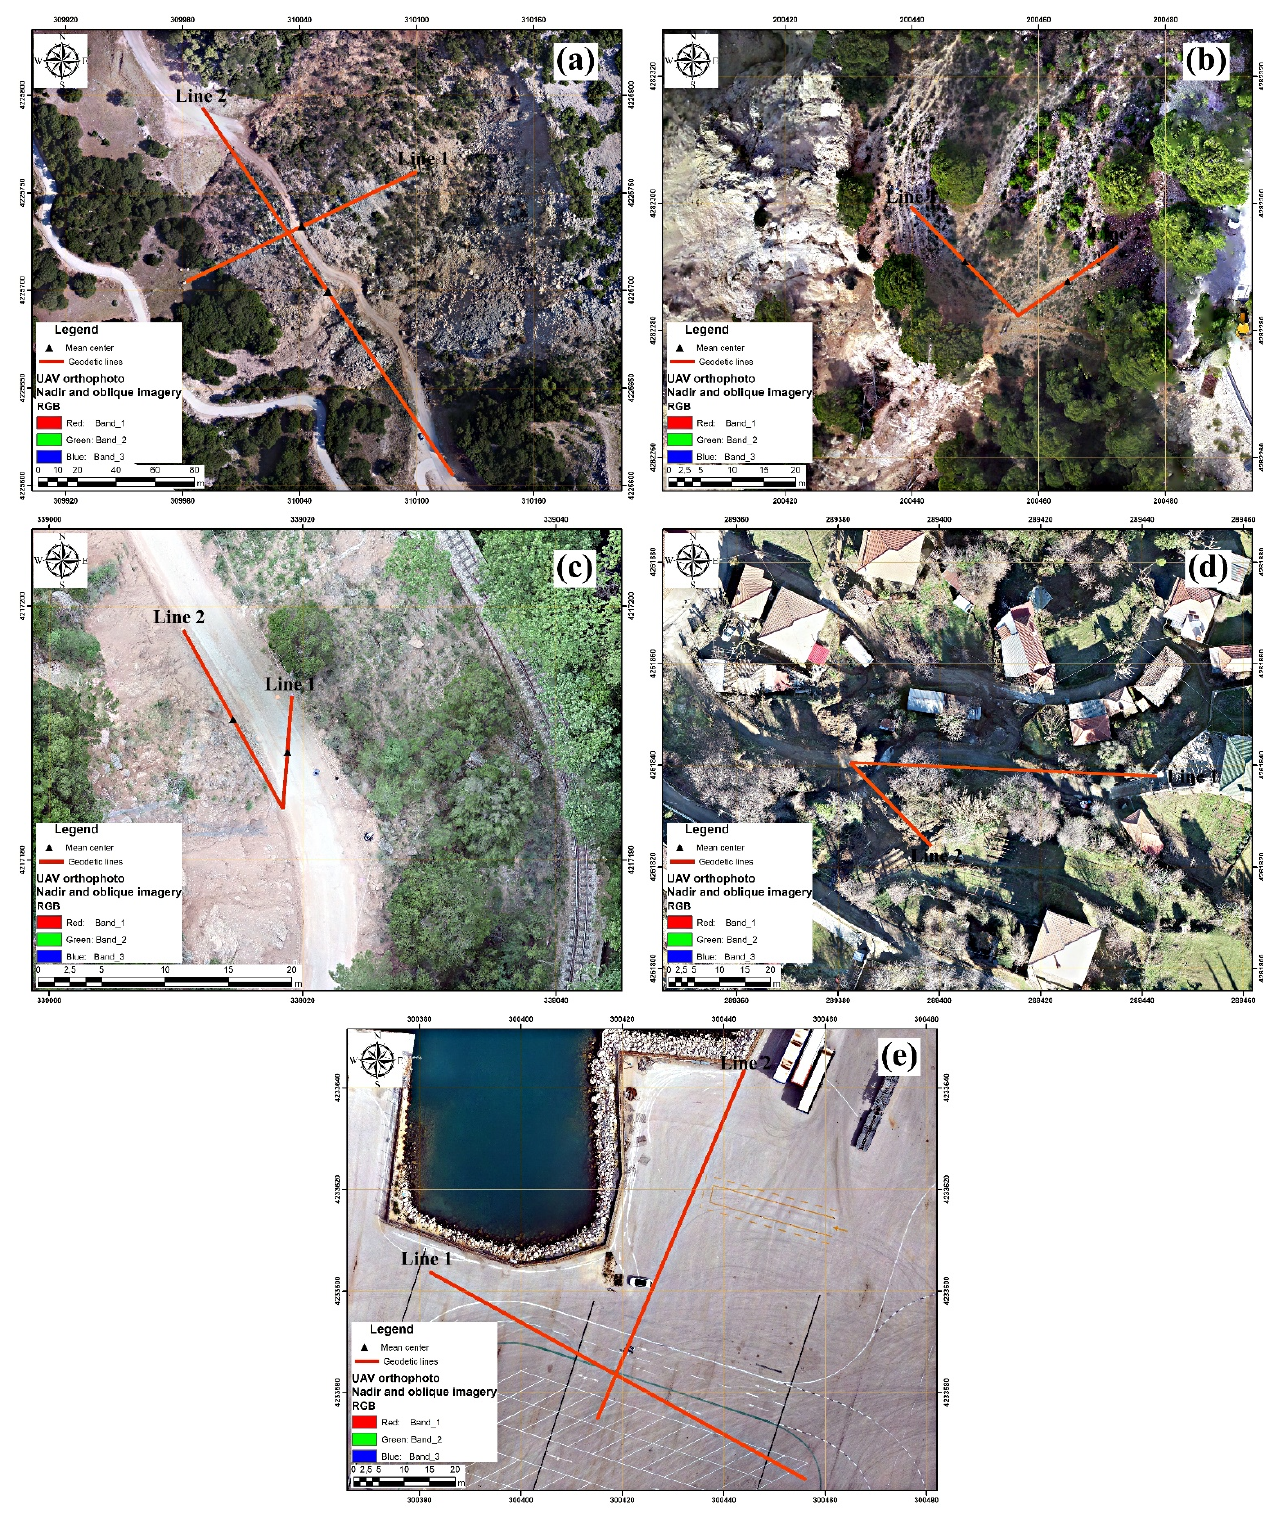
Figure 7. Reference geodetic lines as created in: ( a ) case study 1, ( b ) case study 2, ( c ) case study 3, ( d ) case study 4, and ( e ) case study